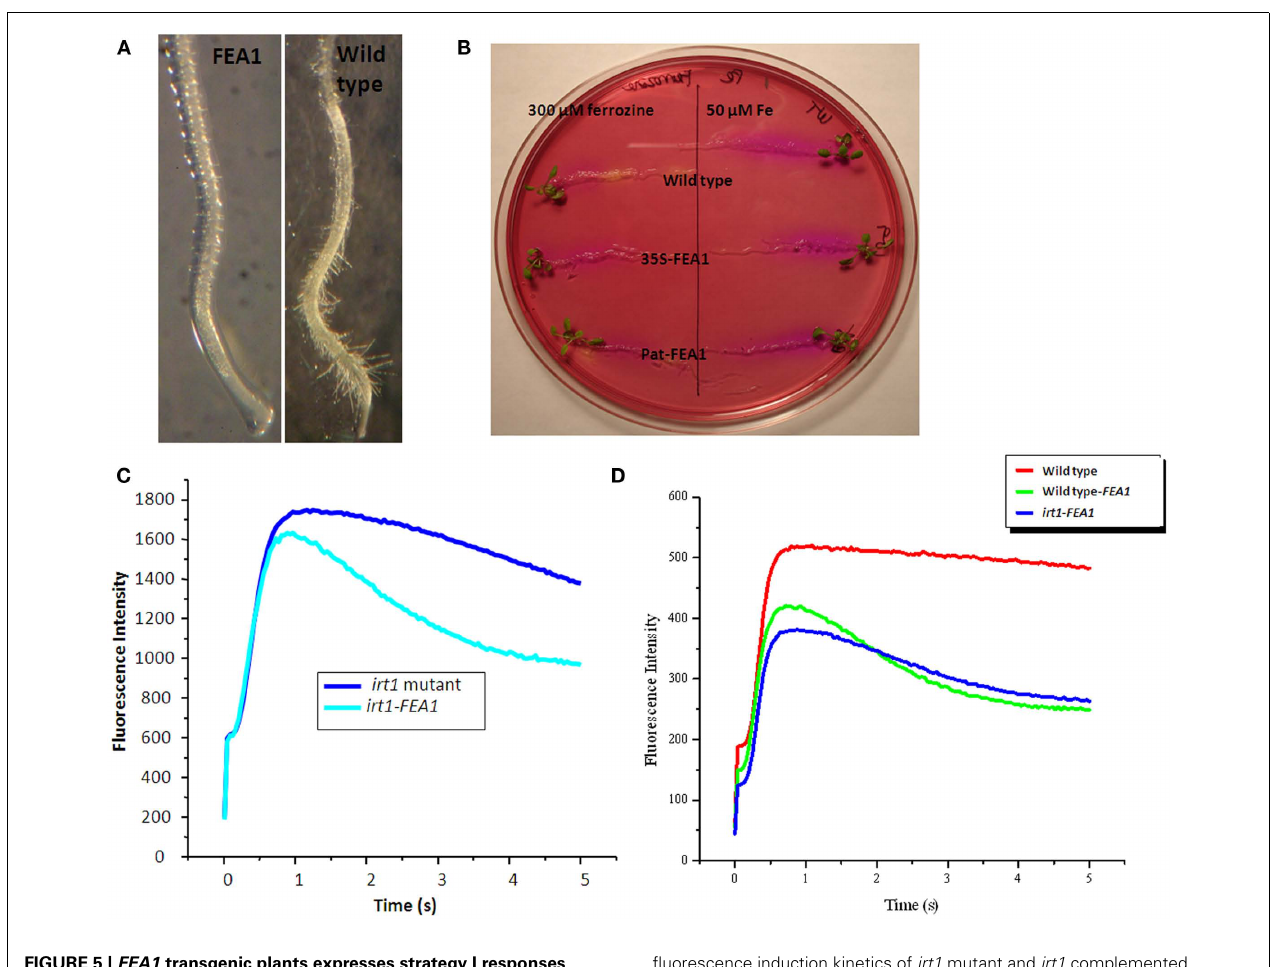
FIGURE 5 | FEA1 transgenic plants expresses strategy I responses under iron-deficient growth conditions. (A) Lateral root branches of wild-type and FEA1 transgenic plants grown in iron-deficient media. Pictures were taken at day 10. (B) Iron deficiency induced acidification of the rhizosphere in wild-type and FEA1 transgenic roots. (C) Chlorophyll